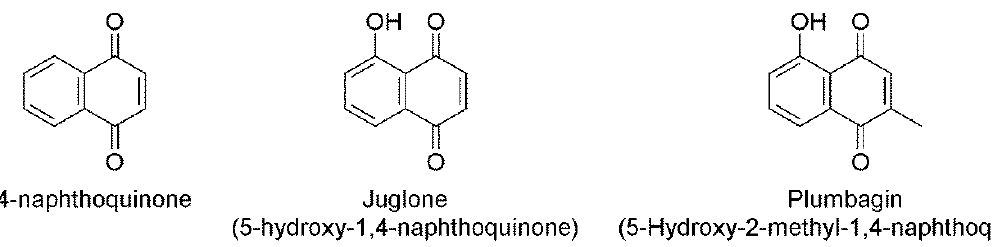
Figure 5. Structure of the three naphthoquinones.